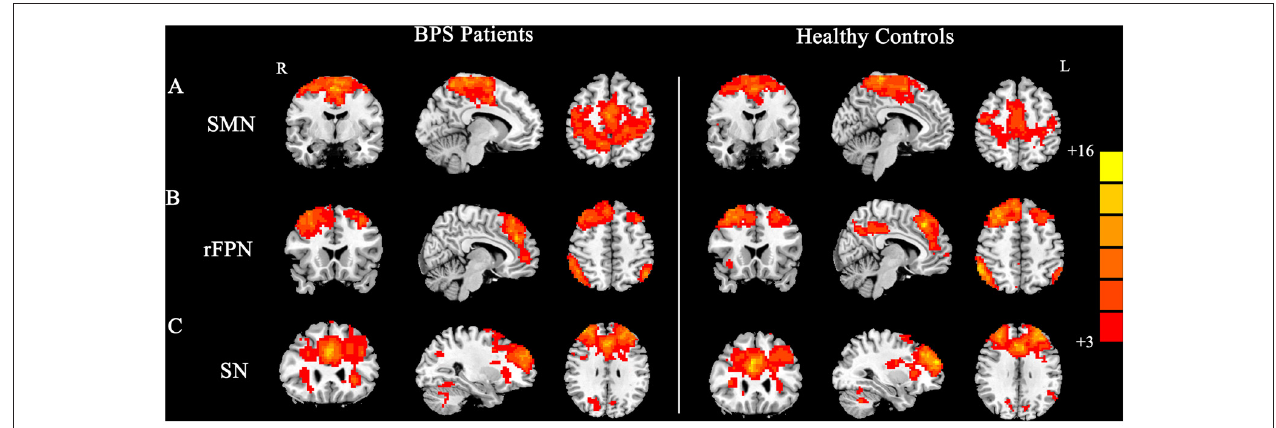
FIGURE 1 | Group maps of the networks showing statistically significant differences between patients and controls: (A) sensorimotor network (SMN), (B) right frontoparietal network (rFPN), (C) salience network (SN).